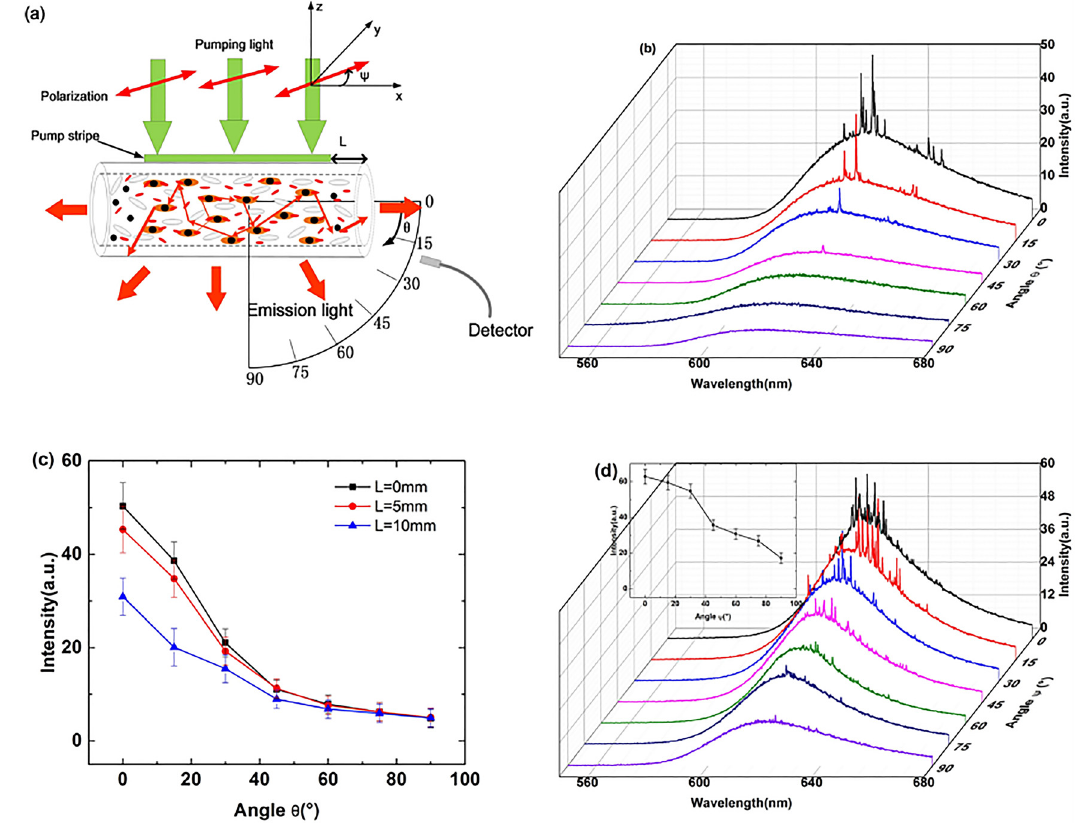
Figure16: (a)Aschematicillustrationoftheemissionspectrumisdetectedatdifferentangles.(b)Theemissionspectrumdetectedatdifferent angle θ from the NPDDNLC sample with 1.186 × 1011/ml in TiN NPs number density, when L = 0 mm, ψ = 0 ° . (c) The peak intensity of the emissionspectrumasafunctionoftheangle θ ,when L =0,5,and10mm.(d)TheemissionspectrumoftheNPDDNLCsamplewith5.314 ×